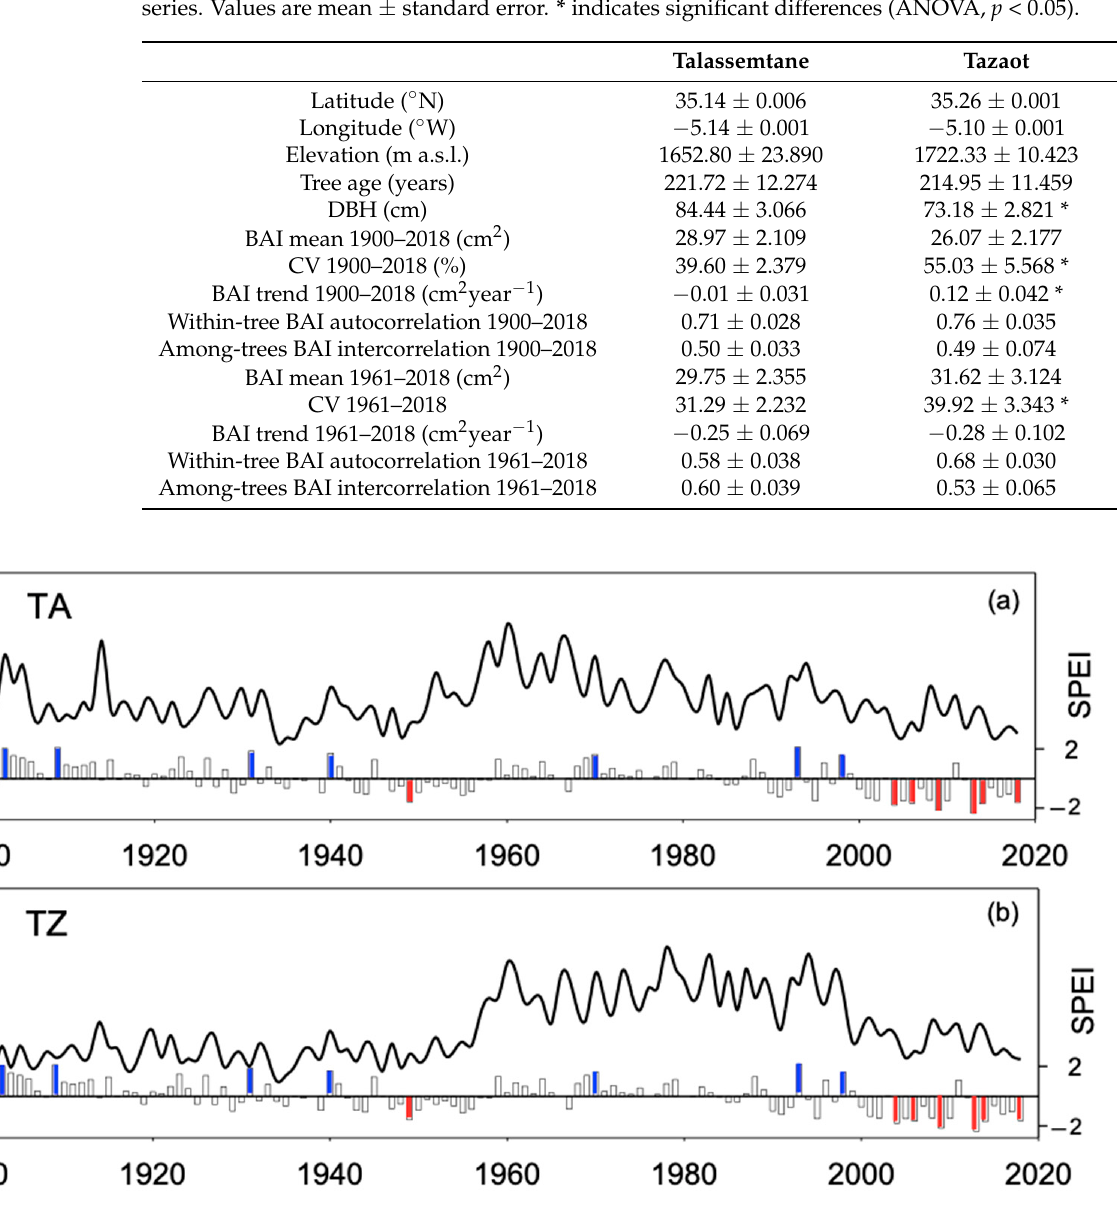
Figure 3. Climate sensitivity (correlation) of mean growth (mean basal area increment) for the pe- riod 1961–2018 of Abies marocana trees from Talassemtane, TA ( a ) and Tazaot, TZ ( b ) ranges. Sensi- tivity was tested at seasonal and annual scales for mean temperature (red), total precipitation (blue), and the SPEI drought index (purple). Seasonal scale was defined by mean (sum) of three-monthly scale temperature (precipitation), while seasonal-scale SPEI data were directly obtained from the database using the available three months estimates (noted as SPEI_3); similarly, annual estimates